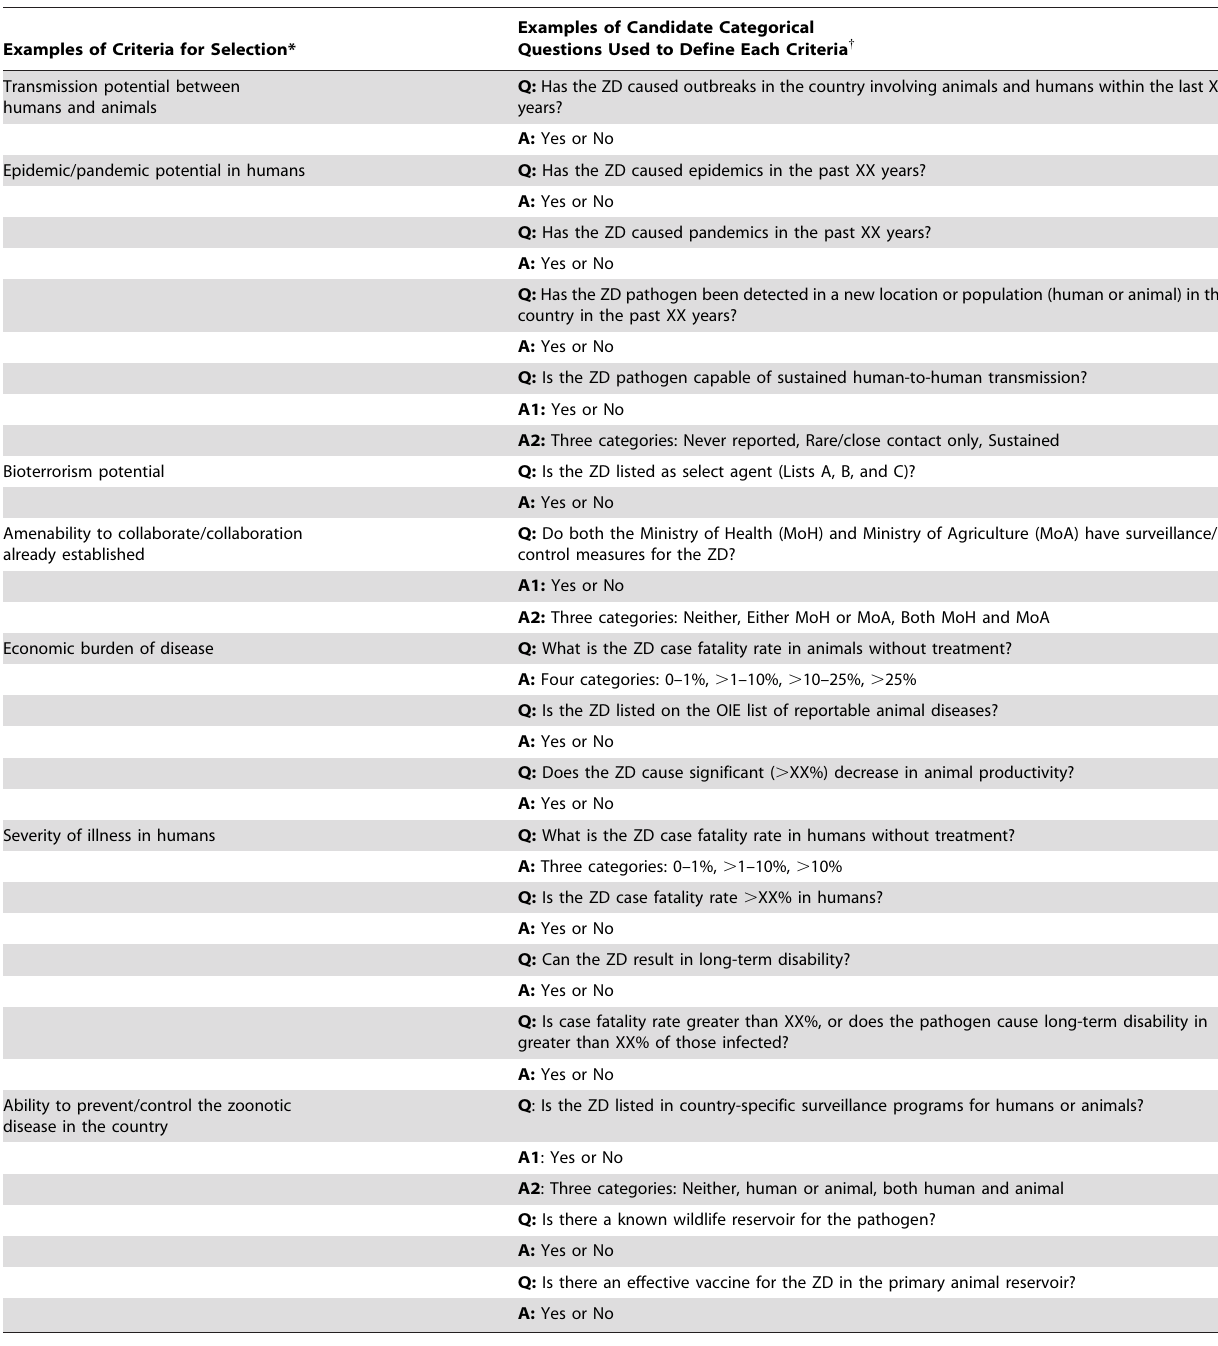
Table 3. Example criteria and categorical questions used in Steps 2 and 3 of the OHZDP Tool to prioritize zoonotic diseases (ZD).